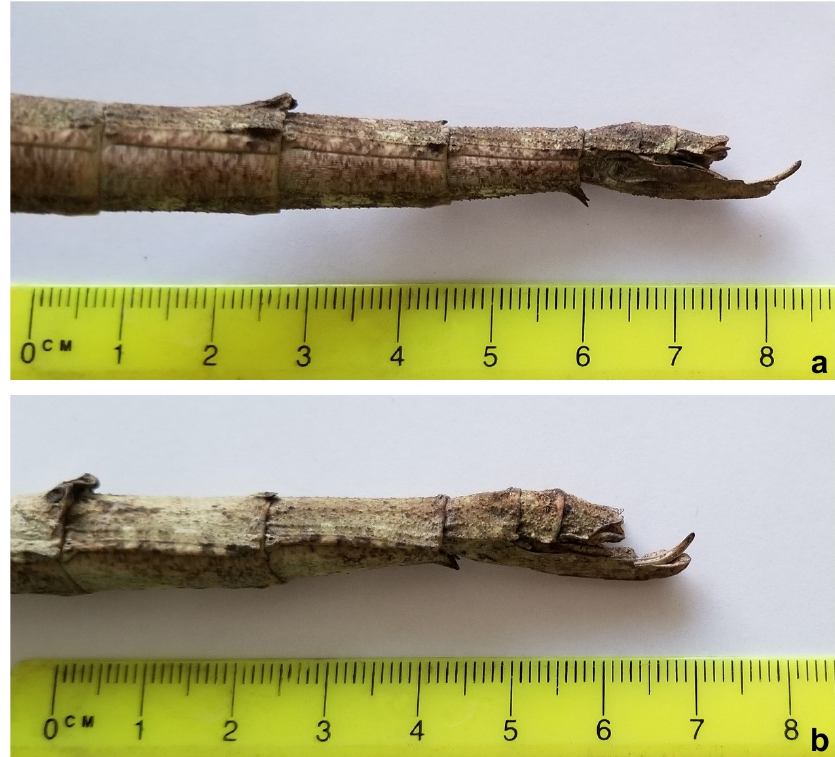
Figure 4. Ovipositor in lateral view. ( a ) Cladomorphus petropolisensis , measuring from the base of the subgenital plate (8th sternum) until the apex of the gonapophyses, is 24.5 mm, longer than the 7th + 8th tergum segments (21 mm); ( b ) C. phyllinus presenting a relative shorter subgenital plate and gonapophyses (25.3 mm), slightly shorter than the 7th + 8th tergum segments (28